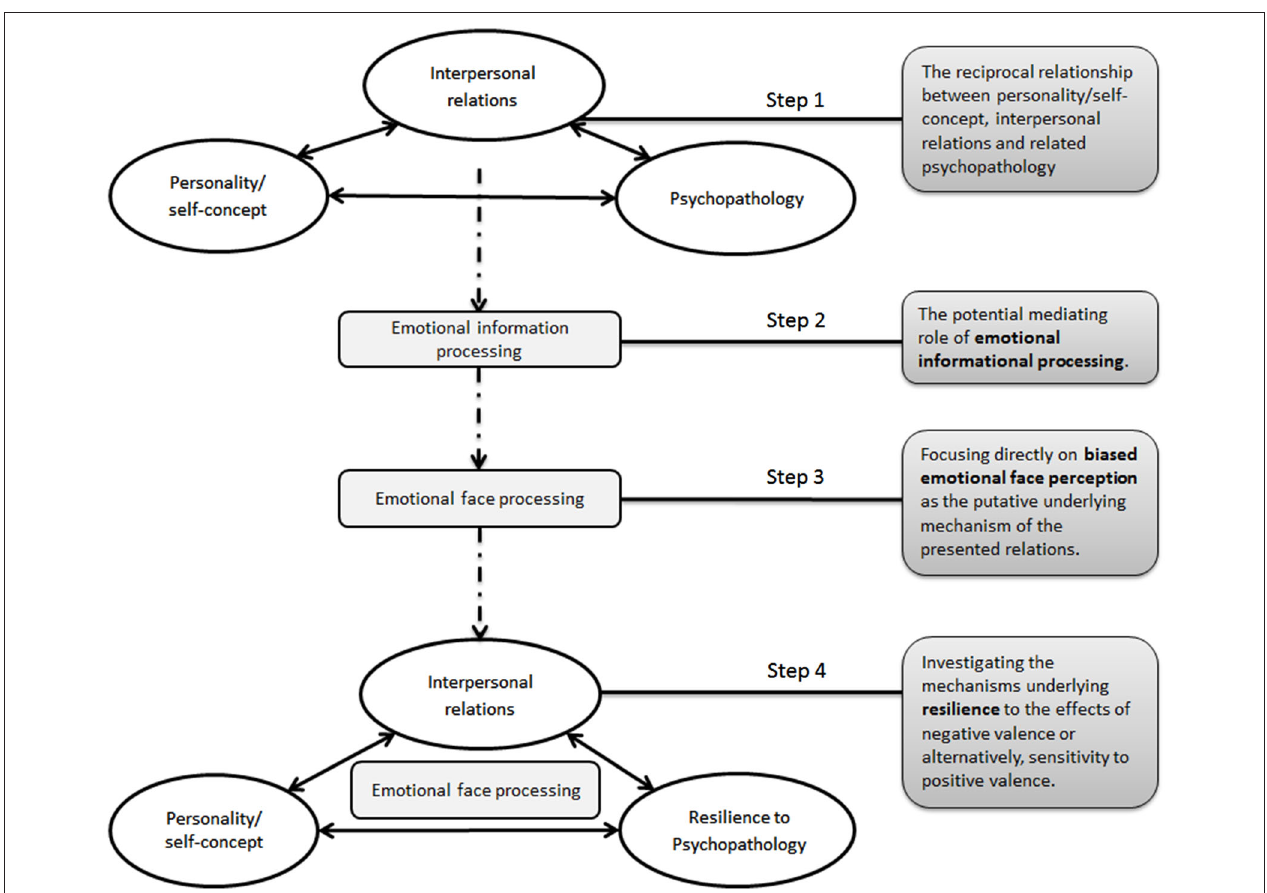
FIGURE 1 | The proposed theoretical model suggesting biased emotional face perception as the putative underlying mechanism of the reciprocal connections between personality/self-concept, interpersonal relations and resilience to psychopathology . See the boxes in the right panel for the related steps that led us to develop this overarching